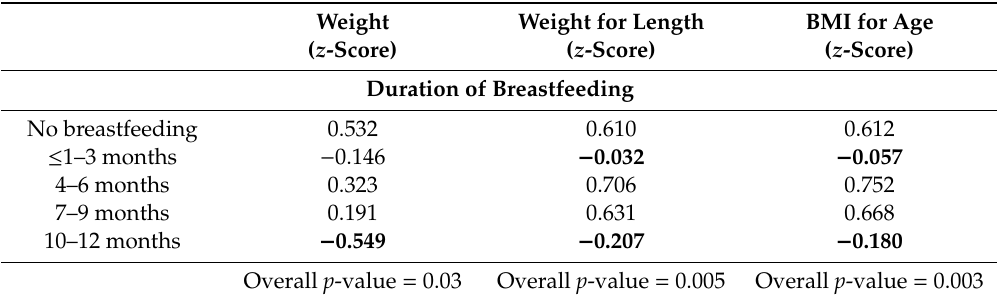
Table 4. Anthropometric measurements of the infants based on the duration of breastfeeding ( n = 101).